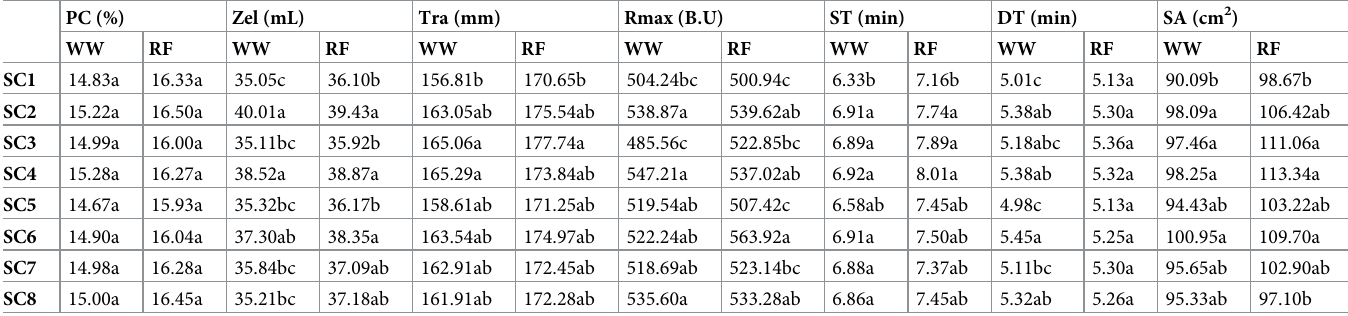
Table 3. Effects of glutenin subunits on quality traits.